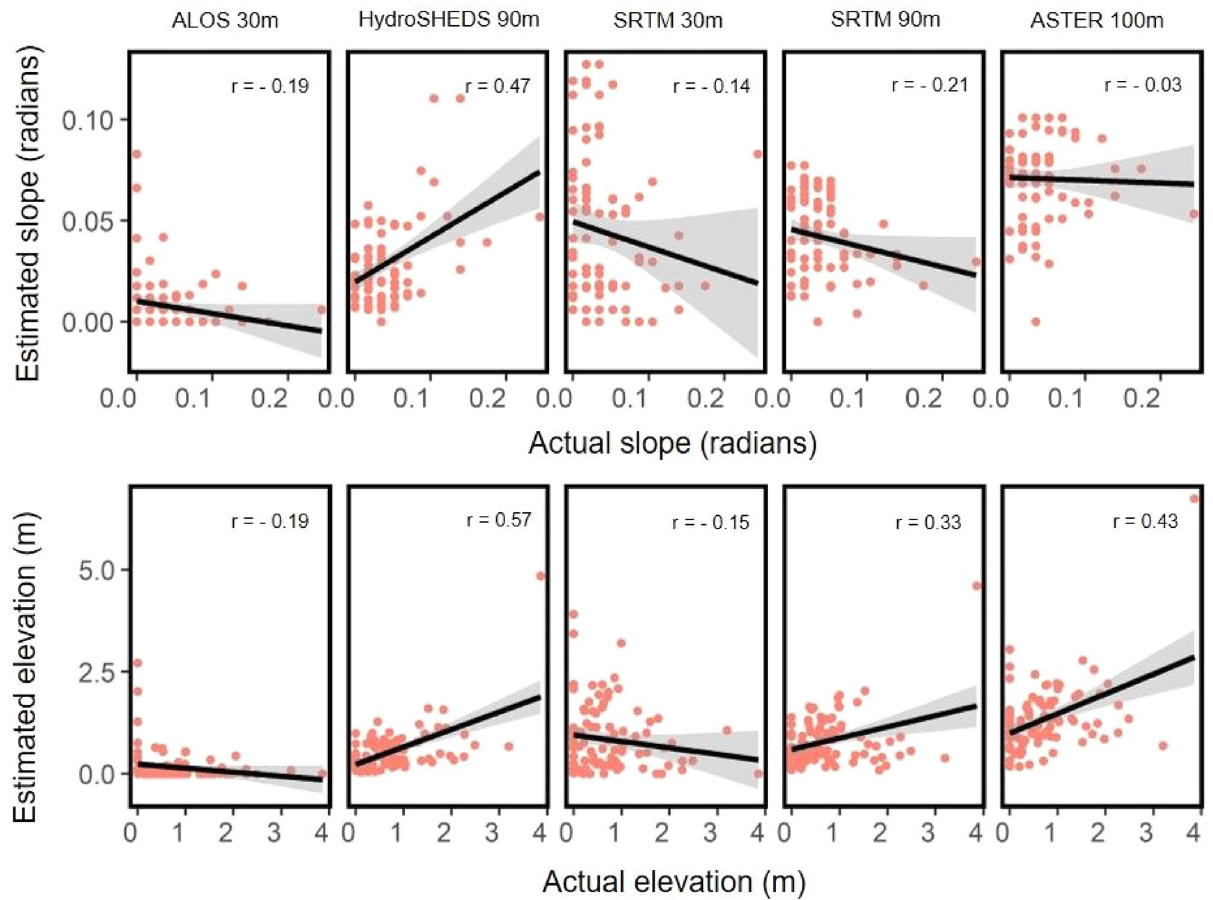
Figure 3. Summary of actual vs. estimates of slope and elevation by DEM. Comparison of the relationship between slope (radians) and elevation (m) using empirical data (in situ measurements) and DEMs for turtle nesting beaches in Costa